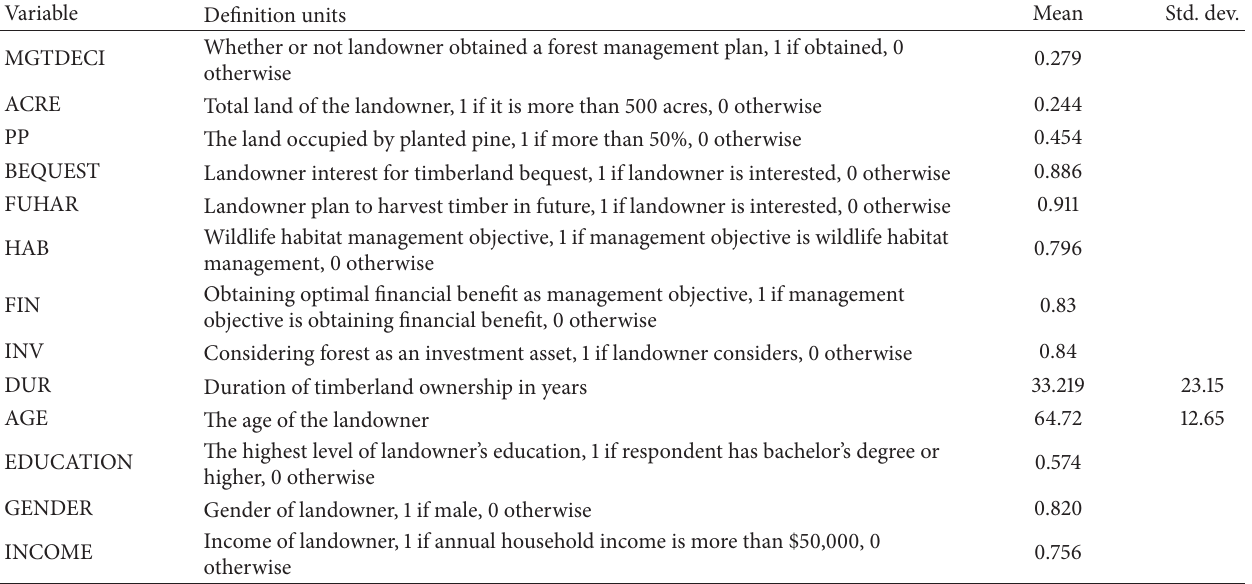
Table 1: Definition and descriptive statistics of variables used in the model for landowner decision to prepare forest management